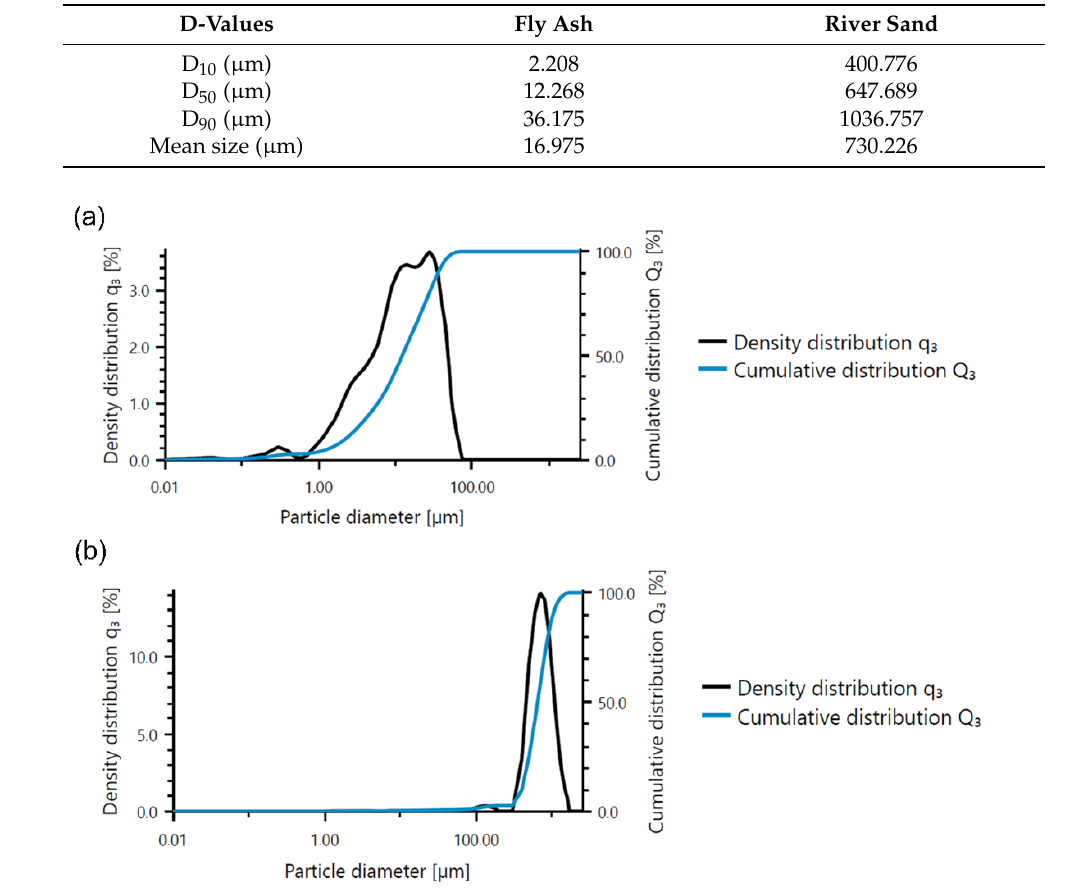
Figure 1. Analysis of particle size of based materials: ( a ) fly ash and ( b ) river sand.